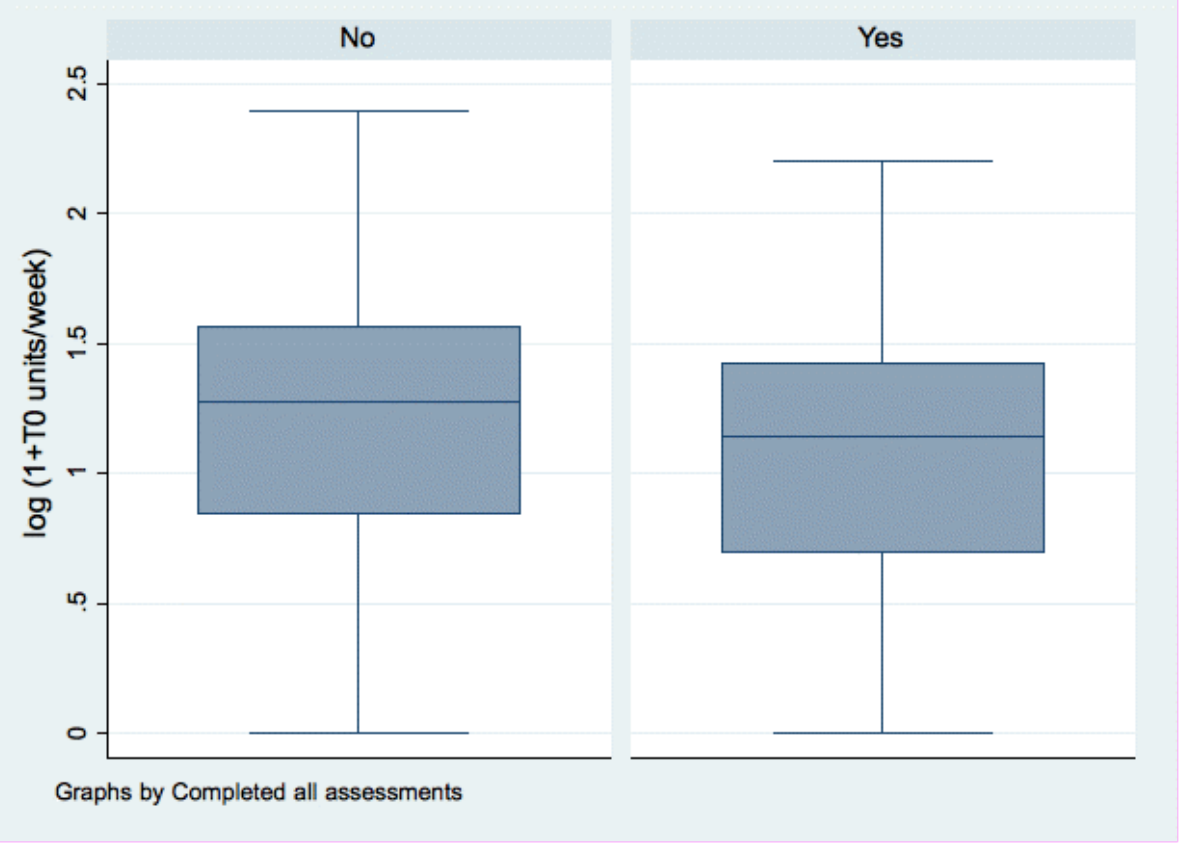
Table 5. Completion status by treatment arm Treatment Arm